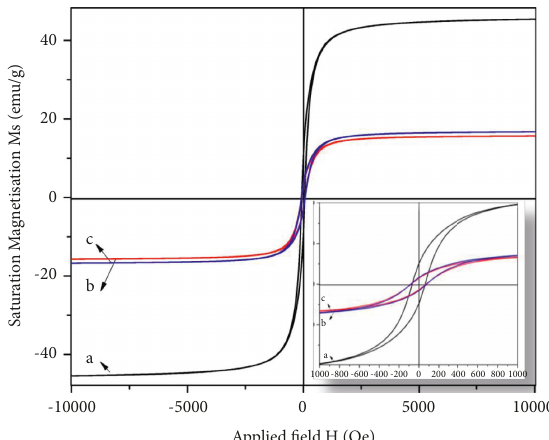
Figure 9: M-H curves of (a) NiFe 2 O 4 , (b) NiFe 2 O 4 @TiO 2 , and (c) NiFe 2 O 4 @TiO 2 @rGO core@shell nanoparticles.